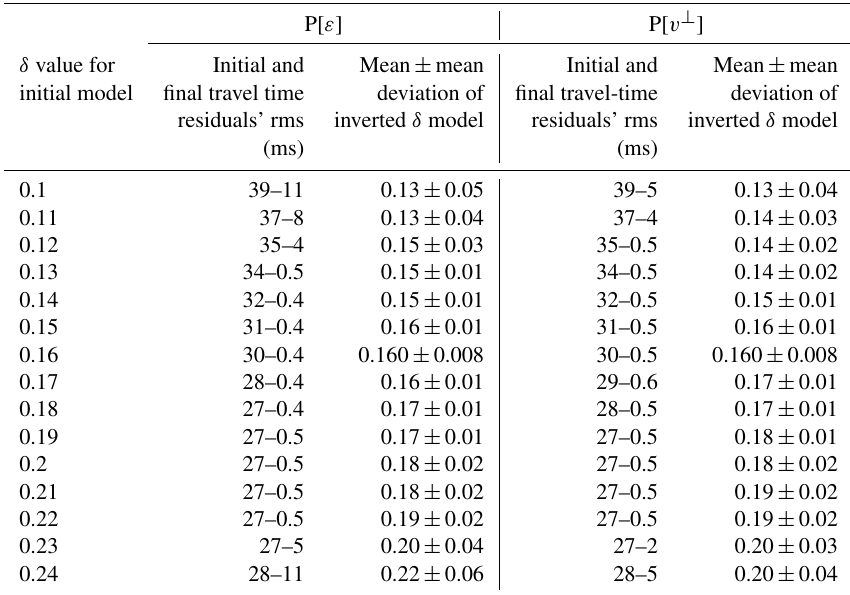
Table 9. Results of the procedure to approximate an initial δ model. The rms of the final travel-time residuals shows a clear change in order of magnitude in the subranges (0.13, 0.22) and (0.12, 0.22) depending on the parameterization. Results for initial δ = 0 . 16 correspond to the examples in Figs. 5 and 6. P[ ε ] P[ v ⊥ ] δ value for Initial and Mean ± mean Initial and Mean ±